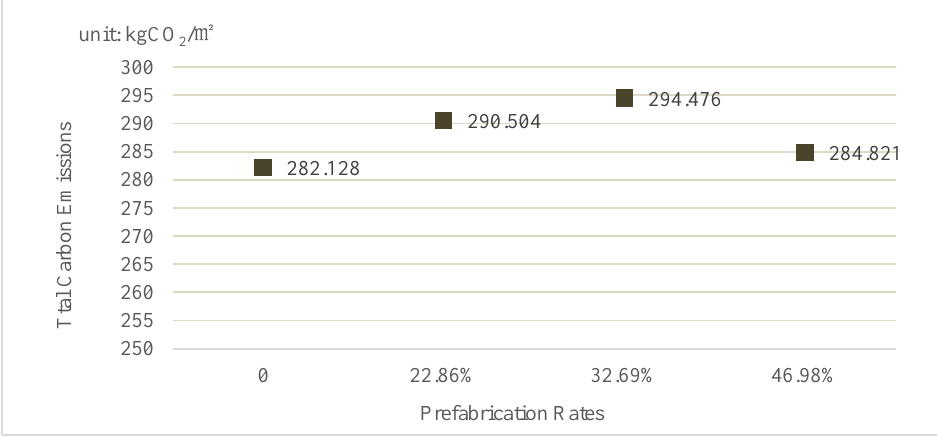
Figure 4. The Total Carbon Emissions of the Case Building under Different Prefabrication Rates.